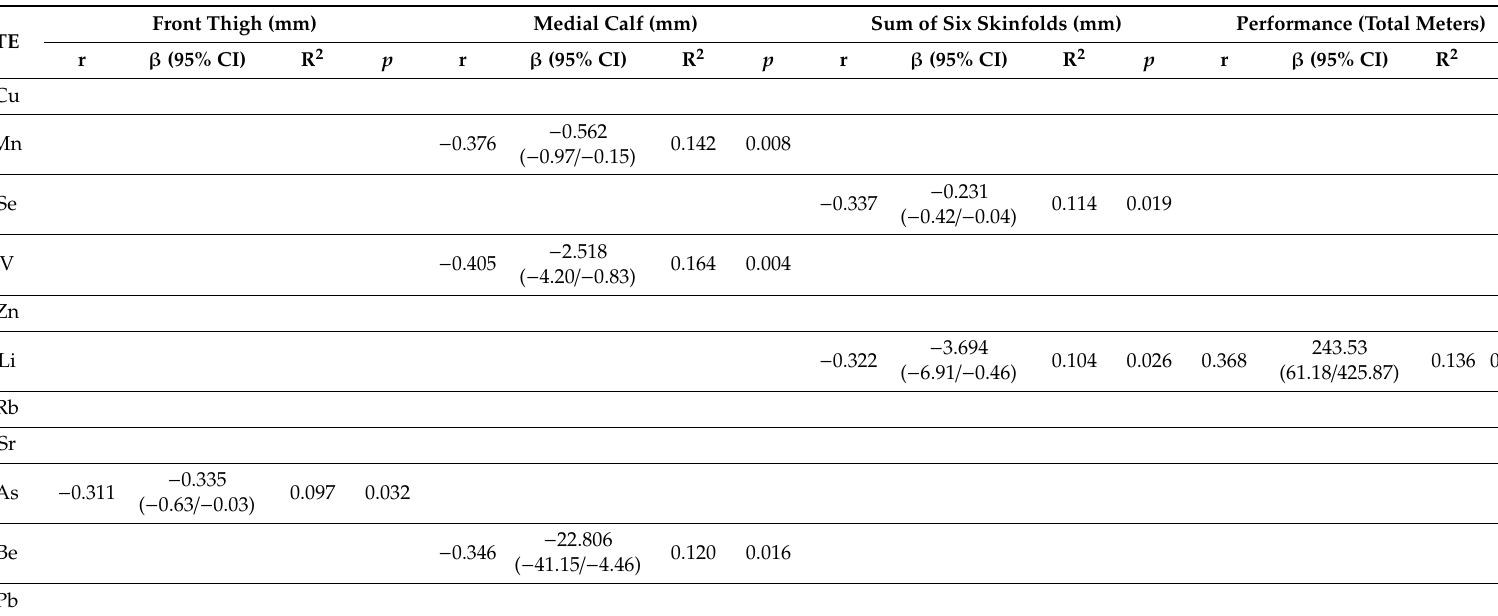
Table 5. Correlations between front thigh and medial calf skinfolds and the sum of six skinfolds, as well as the total meters in the incremental test with trace elements in the